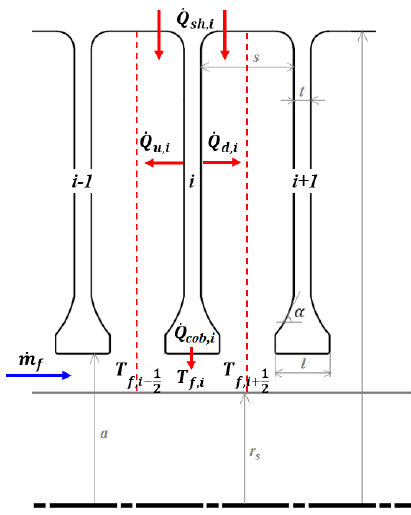
Figure 9. Control volume for temperature rise of axial throughflow [6].